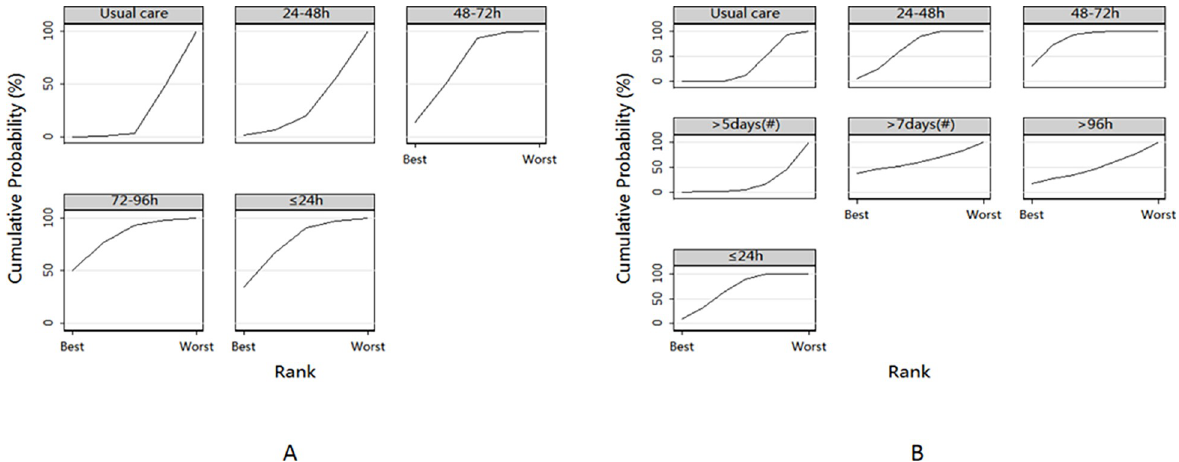
Fig 5. SUCRA: Surface under the cumulative ranking; (#): ICU admitted time.